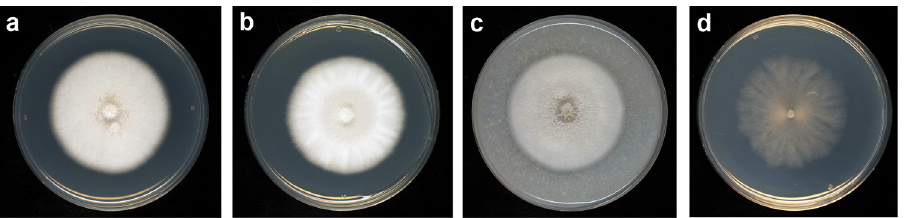
Fig 2. Two-week-old colonies of the K . longispora isolate T15142 from Hungary. The colonies were grown at 25˚C on different media: ( a ) Potato dextrose agar (PDA); ( b ) malt extract agar (MEA); ( c ) oatmeal agar (OA); ( d ) water agar (WA).